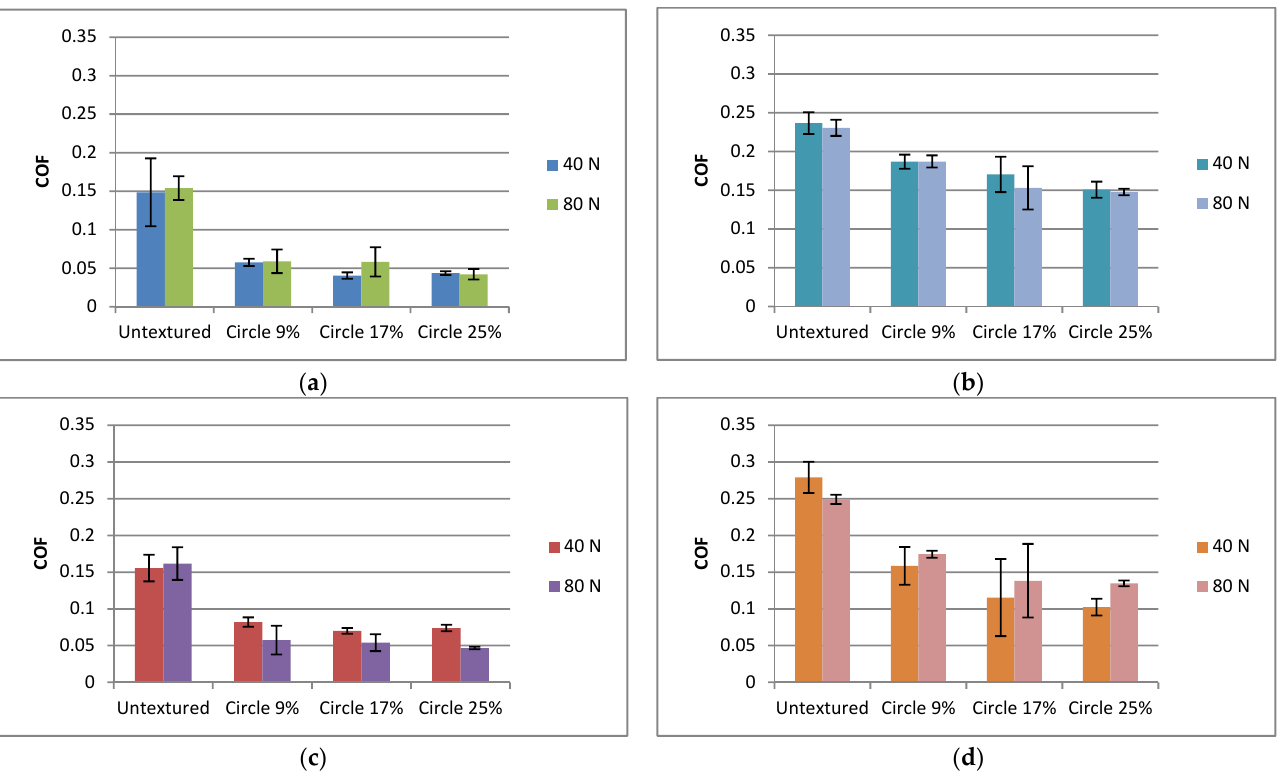
Figure 11. Average values and standard deviations of the coefficient of friction of textured and untextured sliding pairs for the following operating conditions: f = 20 Hz, T = 30 °C ( a ); f = 20 Hz, T = 80 °C ( b ); f= 40 Hz, T = 30 °C ( c ); f = 40 Hz, T = 80 °C ( d ) .